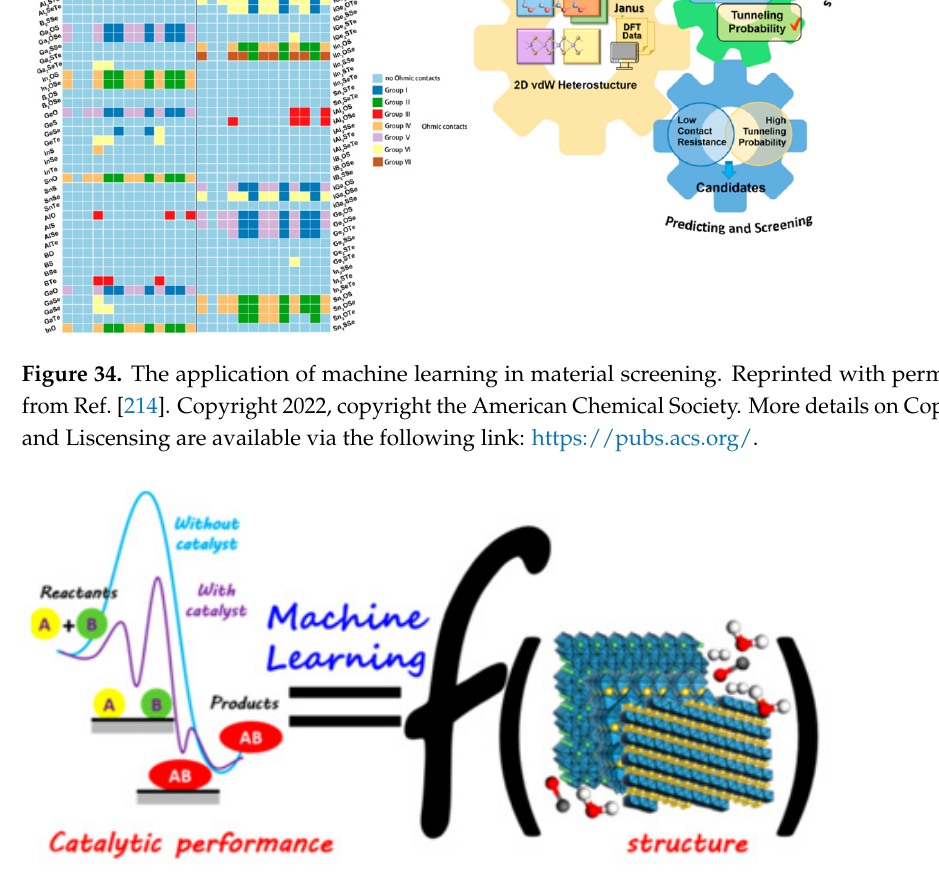
Figure 35. The application of machine learning in material screening. Reprinted with permission from Ref. [235]. Copyright 2020, copyright the American Chemical Society. More details on Copyright and Liscensing are available via the following link: https://pubs.acs.org/. Table 1. Demulsification of heavy oil–water emulsions by non-ionic demulsifiers. Reprinted with permission from Ref. [2]. Copyright 2022, copyright the